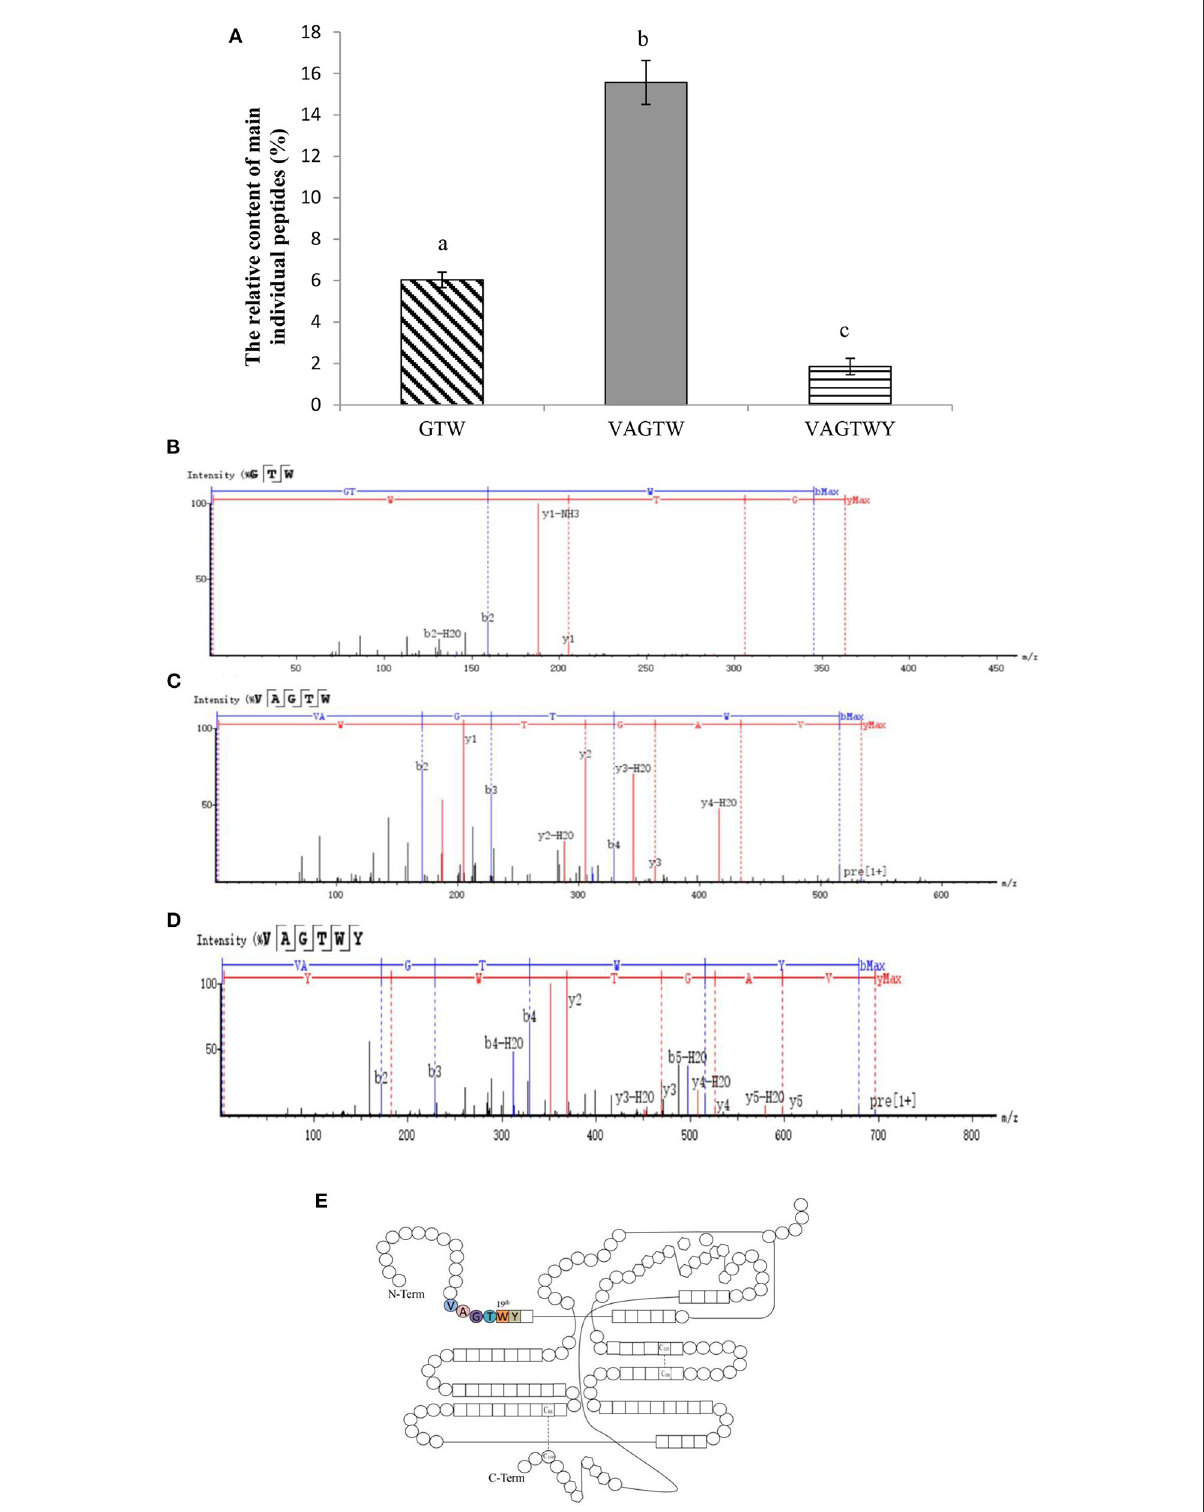
FIGURE2 Characterization of Trp peptides obtained from β -lactoglobulin. Data are expressed as the mean ± SD, and ANOVA was performed to evaluate the difference, followed by the Duncan post-hoc test . (A) The relative content of peptides (GTW, VAGTW, and VAGTWT) produced from β -lactoglobulin. Different letters (a, b, and c) indicate a significant difference ( p < 0.05). The UPLC-Q-TOF MS/MS tandem mass spectra (ESI + ) of (B) GTW (Gly-Thr-Trp), (C) VAGTW (Val-Ala-Gly-Thr-Trp), and (D) VAGTWY (Val-Ala-Gly-Thr-Trp-Tyr) as interpreted by peaks automatic sequencing software. (E) Schematic diagram of the molecular structure of β